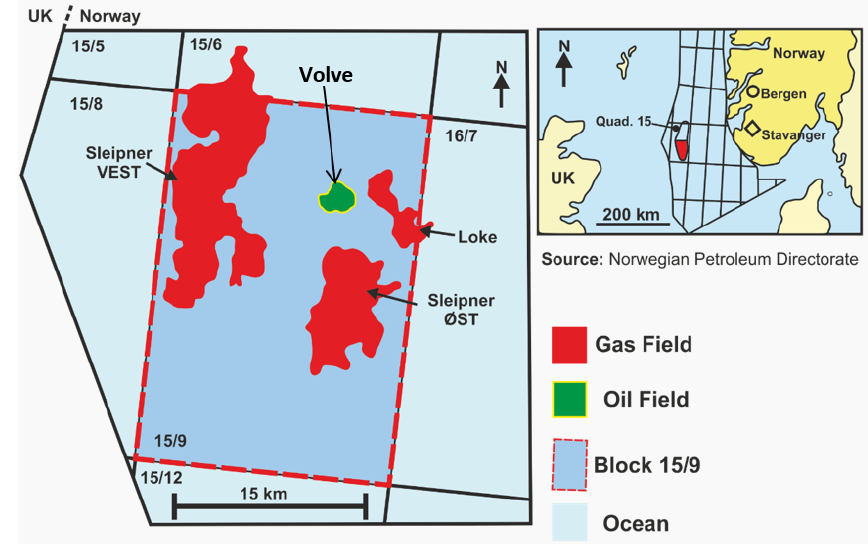
Figure 1. Location map of the Volve field showing gas and oil fields in quadrant 15/9, Norwegian North Sea (from Ravasi et al.,